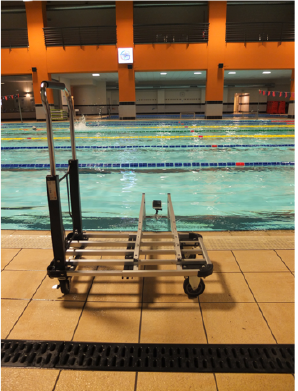
Figure 3: The ad-hoc cart for camera